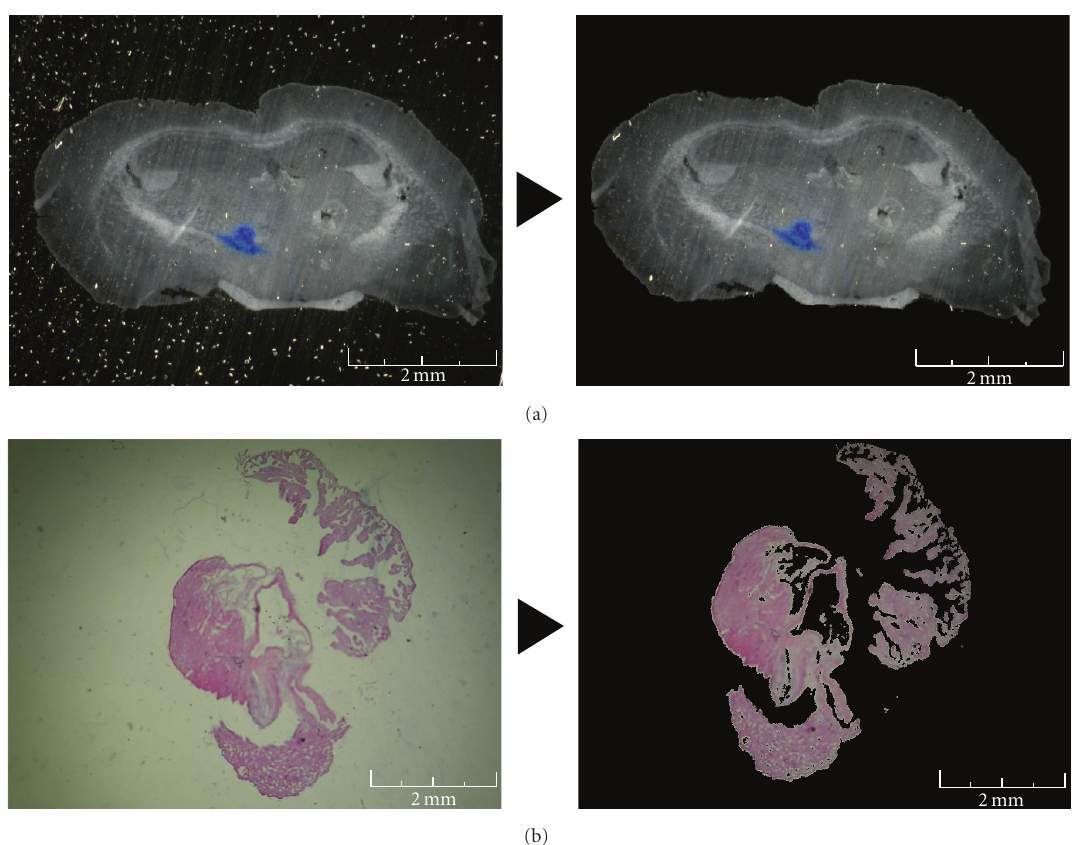
Figure 1: Soil and glare reduction. Soils and glares have been removed in order to have a clear vision of the final model. (a) We have on the left the original image of the section of brain tissue, and on the right the image after soil and glare reduction. (b) The same procedure has been used for heart section